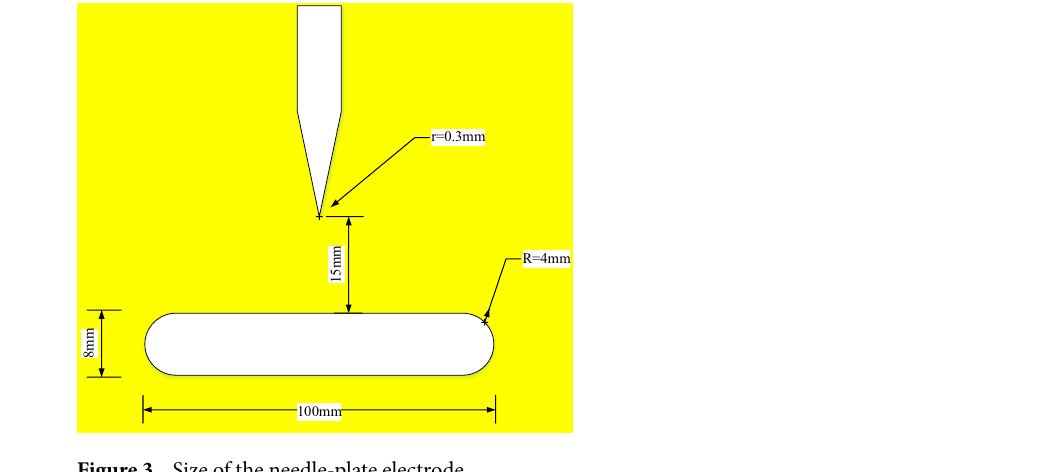
Figure 3. Size of the needle-plate